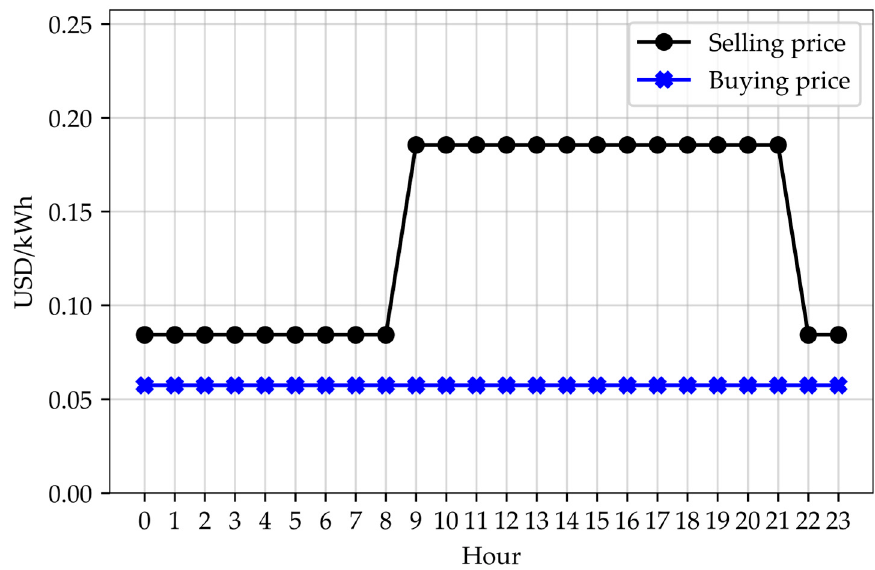
Figure 7. The hourly mean energy prices of Case I.